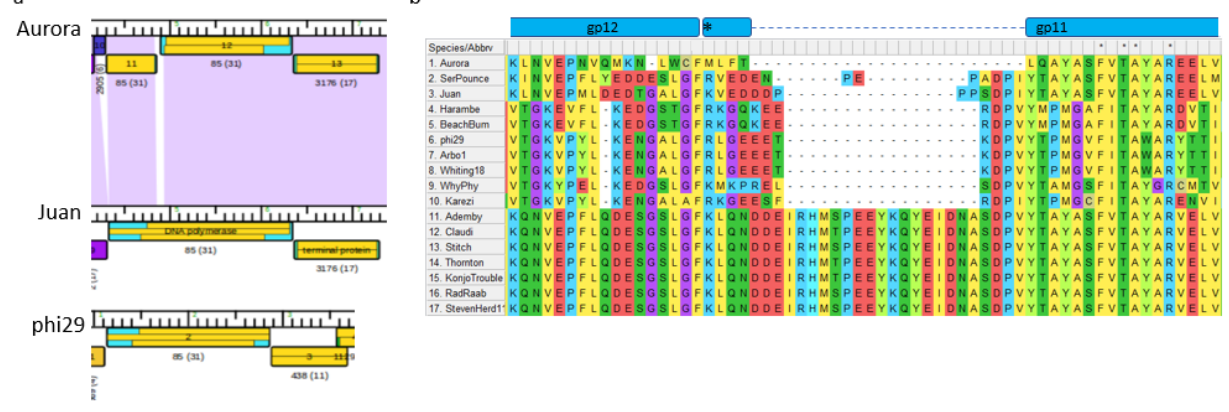
Figure 9 . Mutation in DNA polymerase sequence reveals variable region in essential enzyme. ( a ) Phamerator map of the DNA polymerase protein region of Aurora compared to Juan and phi29. Colored rectangles represent protein families and purple shading between the genomes represents Blastn homology. ( b ) Multiple sequence alignment of the deletion region in Aurora reveals this se- quence is also missing in other DNA polymerase proteins. The asterisk indicates the start methionine for the second region encoding Aurora DNA polymerase (gp 11 in panel a ).